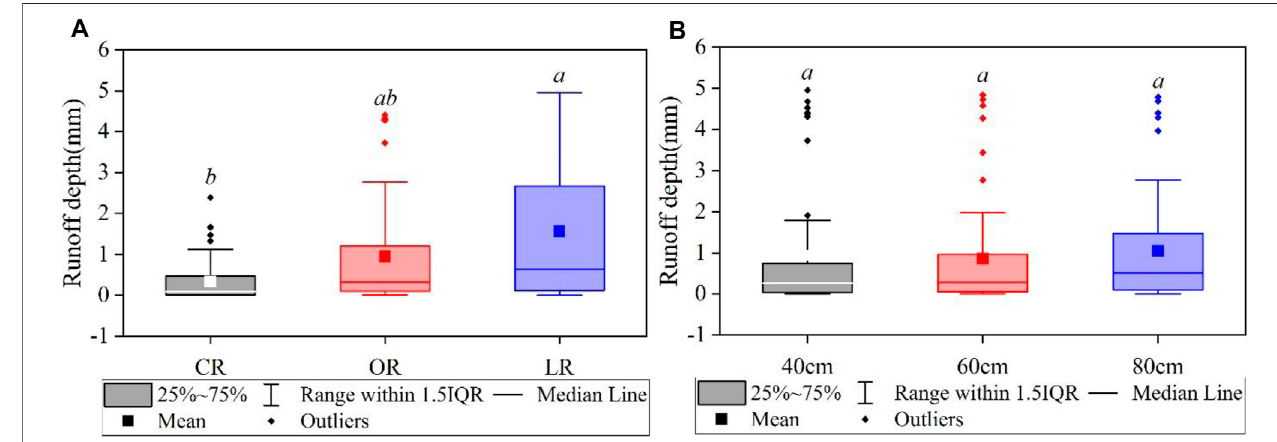
FIGURE3| Runoffdepthunderdifferentridgedirections (A) andridgewidths (B) ,andboxeslabeledwithdifferentlettersindicatesigni fi cantdifferencesat p < 0.05. CR, OR, and LR represent cross-ridge tillage, oblique-ridge tillage, and longitudinal-ridge tillage, respectively. 40, 60, and 80 cm represent 40 cm ridge width, 60 cm ridge width, and 80 cm ridge width, respectively.